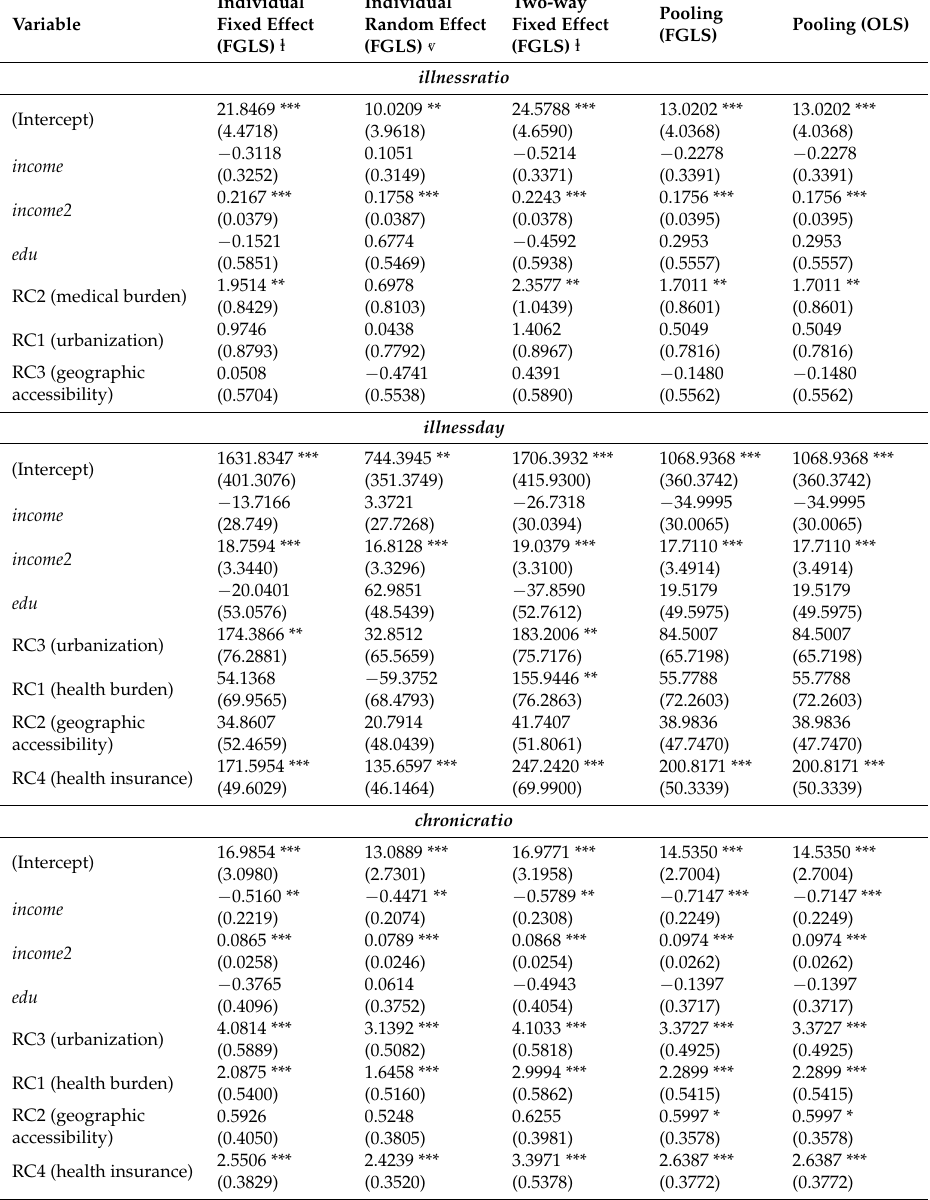
Table A7. Complete regression results (NHSS).